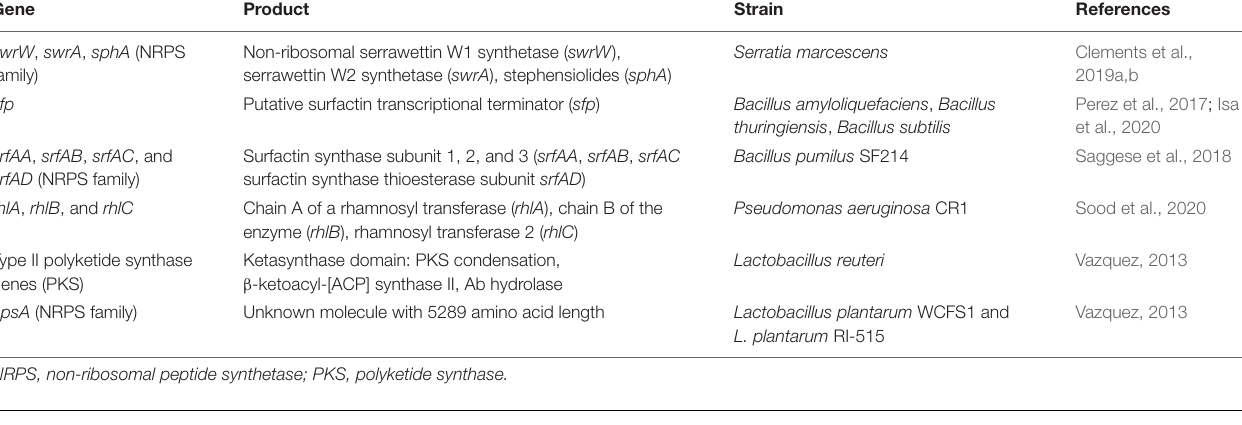
TABLE 1 | List of available genes involved in the biosynthesis of biosurfactant with antimicrobial activity produced by bacteria associated with human health. Gene Product